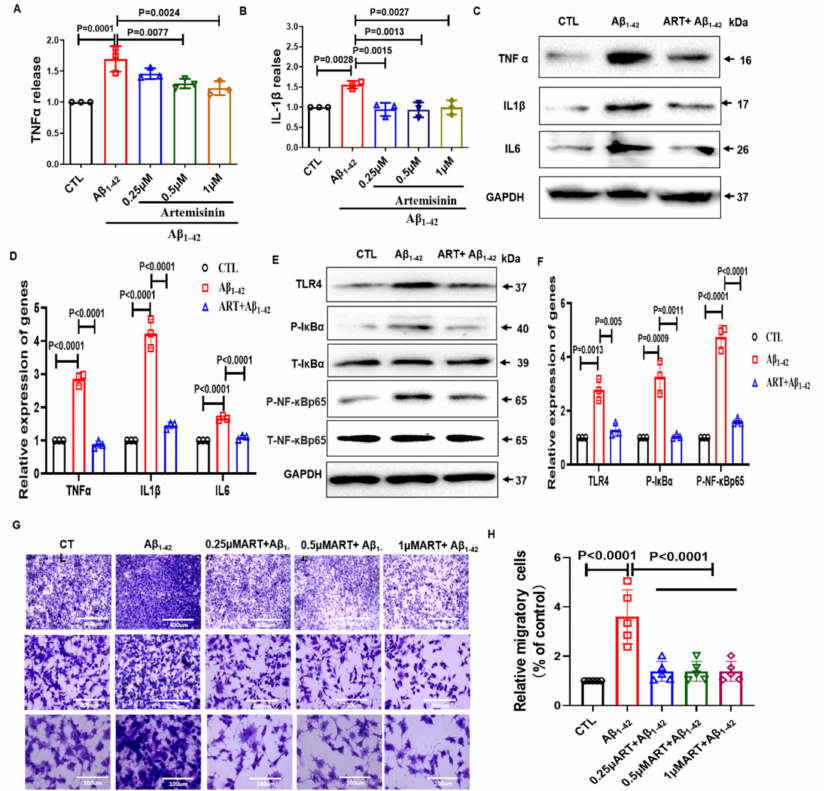
Figure 3. Artemisinin reduced the release of inflammatory factors and inhibited the migratory ability of BV2 cells caused by A β 1–42 . ( A ) ELISA assay checks the effect of Artemisinin on the TNF- α release induced by A β 1–42 . ( B ) ELISA assay checks the effect of Artemisinin on the IL-1 β release induced by A β 1–42 . ( C ) The expression of inflammatory factors was detected by Western blot. ( D ) Quantification of inflammatory factors expression in C. ( E ) Western blot of p-NF- κ B and p-I κ B α in A β induced BV2 cells. ( F ) Quantitation of p-NF- κ B, p-I κ B α in ( E ). ( G ) Transwell chamber migration of BV2 microglial cells. ( H ) The relative migratory cells in the lower chamber. p < 0.05 was considered significantly